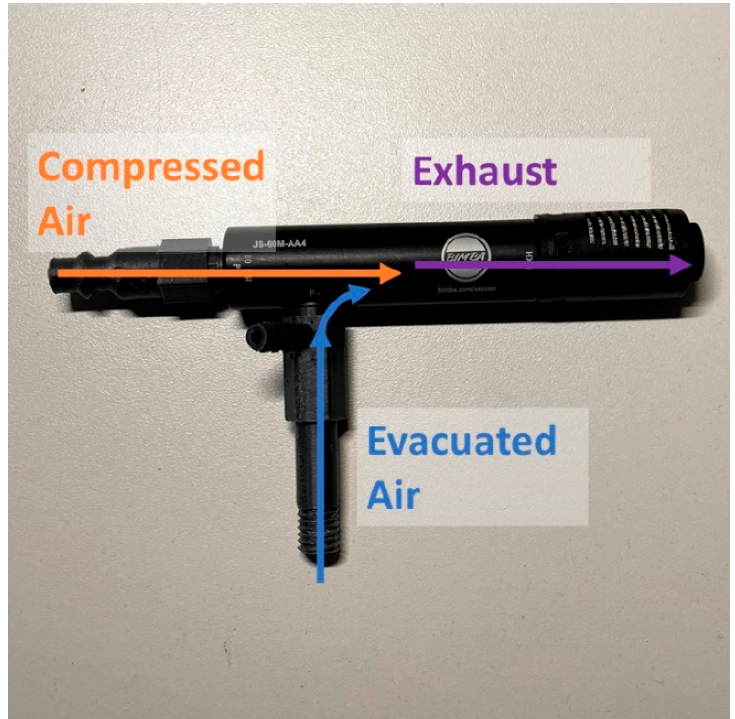
Figure 4. The air ejector is driven by compressed air, which creates a vacuum pressure inside the ejector, pulling air through the vacuum connector into the stream of compressed air. The exhaust is delivered into the atmosphere through a diffuser that reduces airflow noise. With the air ejector assembled and checked, the vacuum inlet was fed through the two circles of insulation. Next, one M10 washer was placed on the inlet (Figure 5a), then the inlet was fed through the lid of the vacuum chamber. The other M10 washer was applied and the M10 nut was tightened onto the threads, securing the air ejector and insulation to the lid (Figure 5b).